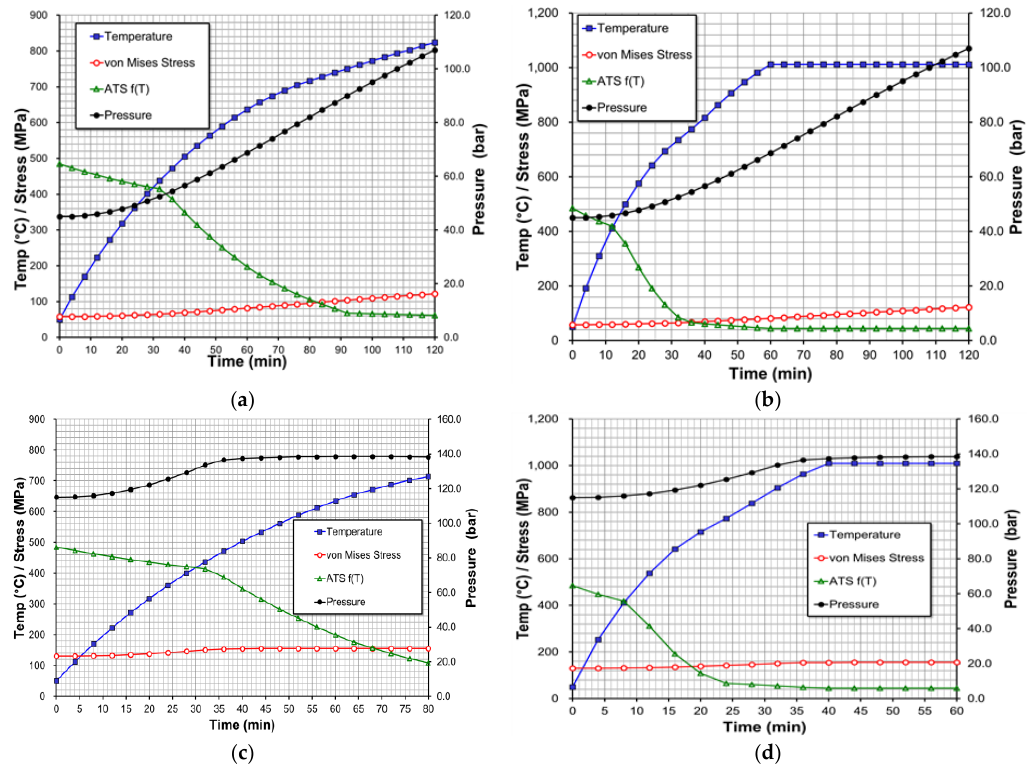
Figure 5. Results for a 3-m diameter vessel with 135 bar design pressure. The graphs show vessel pressure (right axis), temperature (where peak heat load is applied), von Mises stress and ATS (left axis) as a function of time. ( a ) Pool fire scenario at 45 bar; ( b ) jet fire scenario at 45 bar; ( c ) pool fire scenario at 115 bar; and ( d ) jet fire scenario at 115 bar.